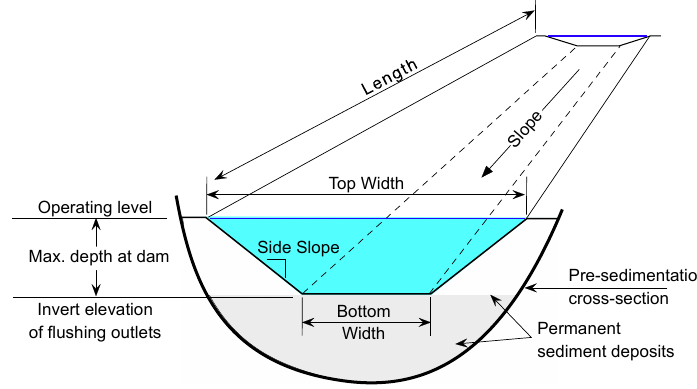
Figure 12. Geometry of scour channel that can be sustained by either flushing or sluicing.